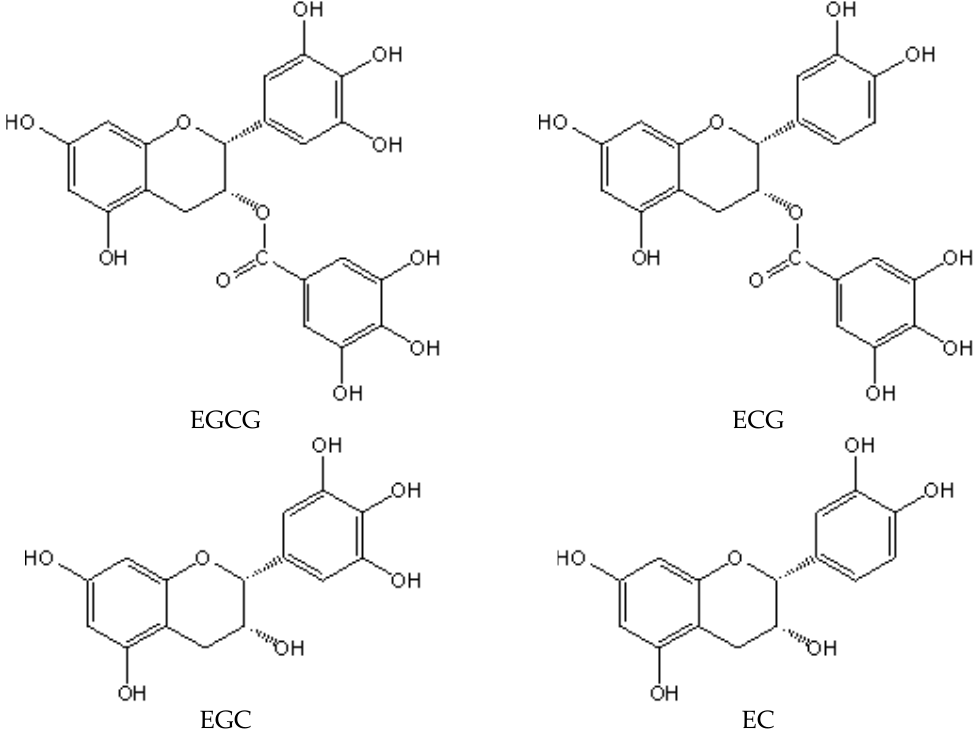
Figure 1. The structures of four kinds of catechins: epicatechin (EC), epigallocatechin (EGC), epicatechin gallate (ECG), and epigallocatechin gallate (EGCG) [25].